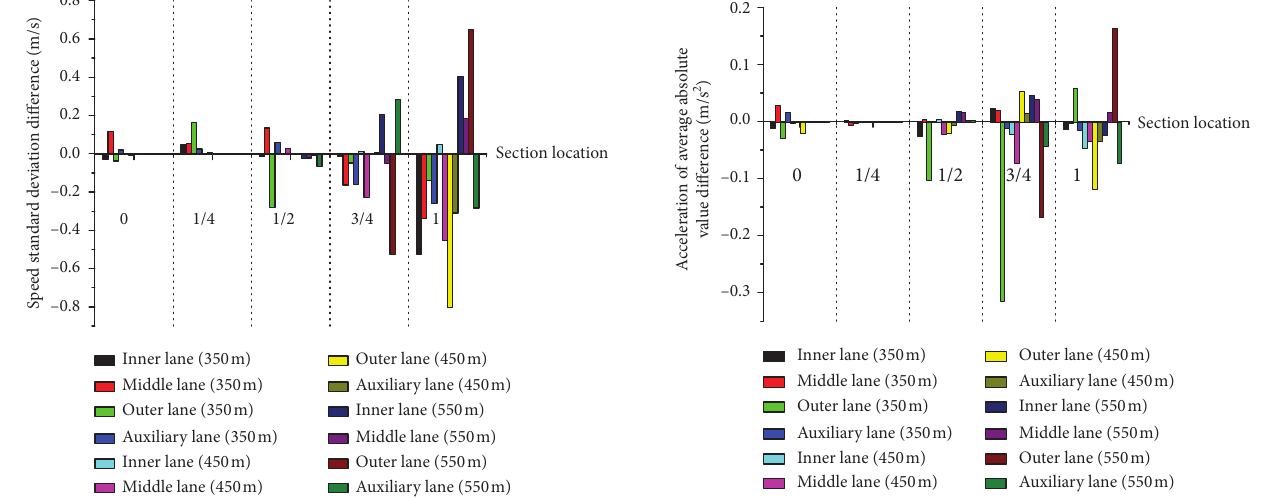
Figure 8: The speed standard deviation difference between the optimized method and the original design.